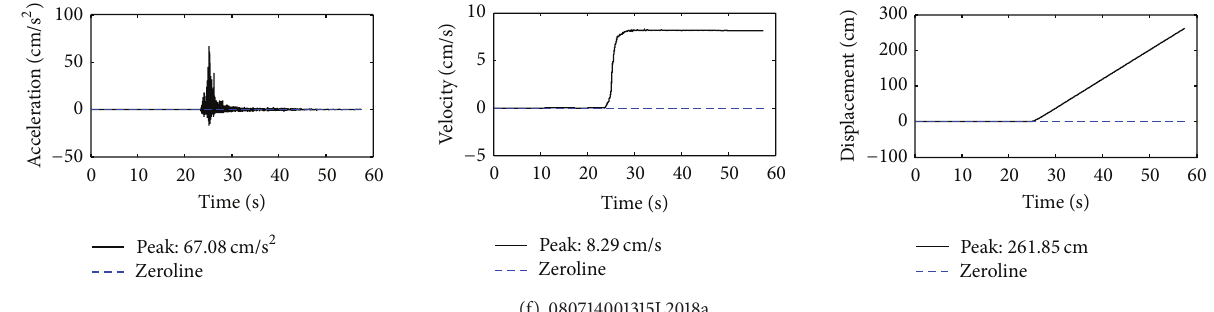
Figure 15: Acceleration, velocity, and displacement time history.